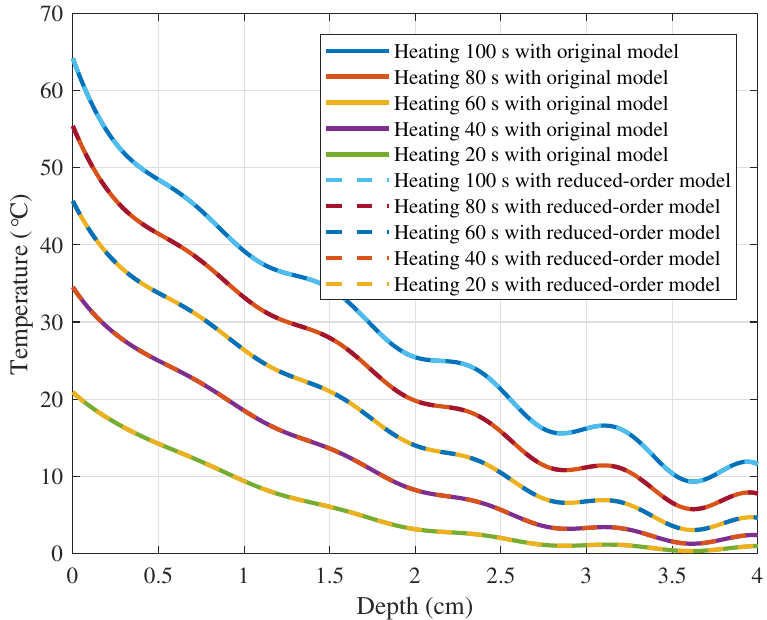
Figure 6. Comparison between the reduced-order model and original model for the spatial tempera- ture distribution at 100 s, 80 s, 60 s, 40 s and 20